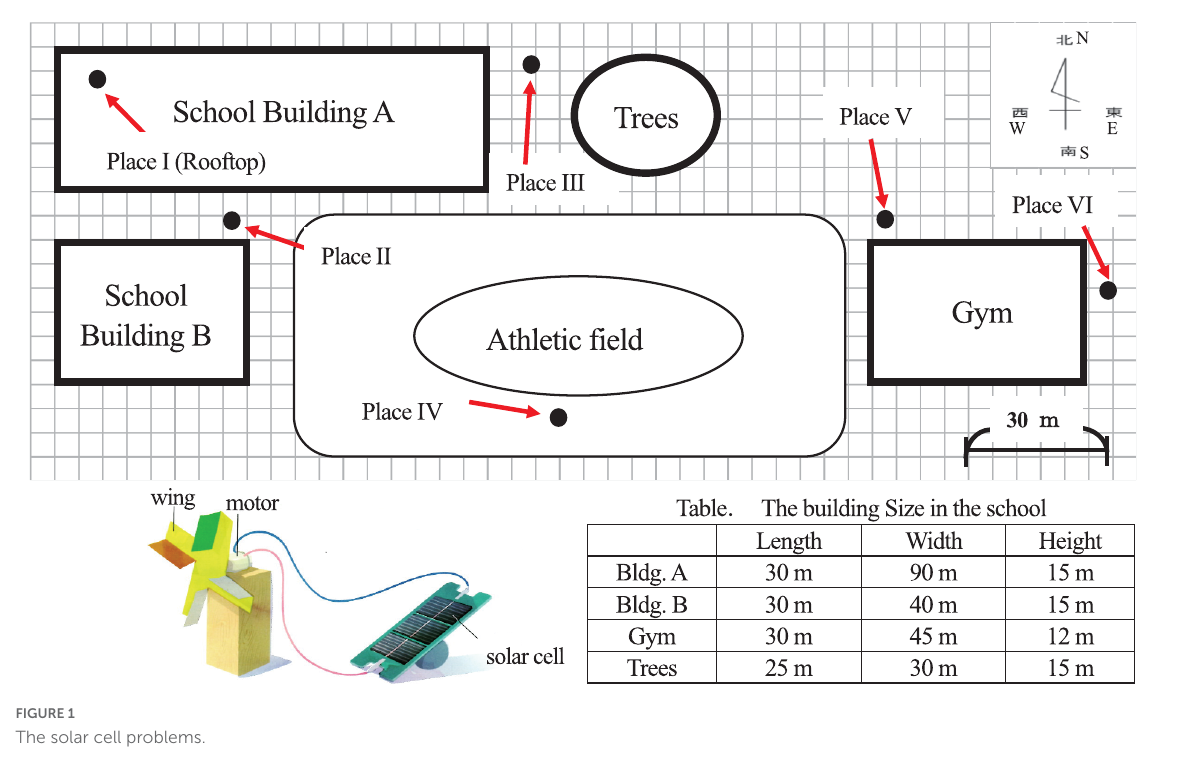
FIGURE1 The solar cell problems.